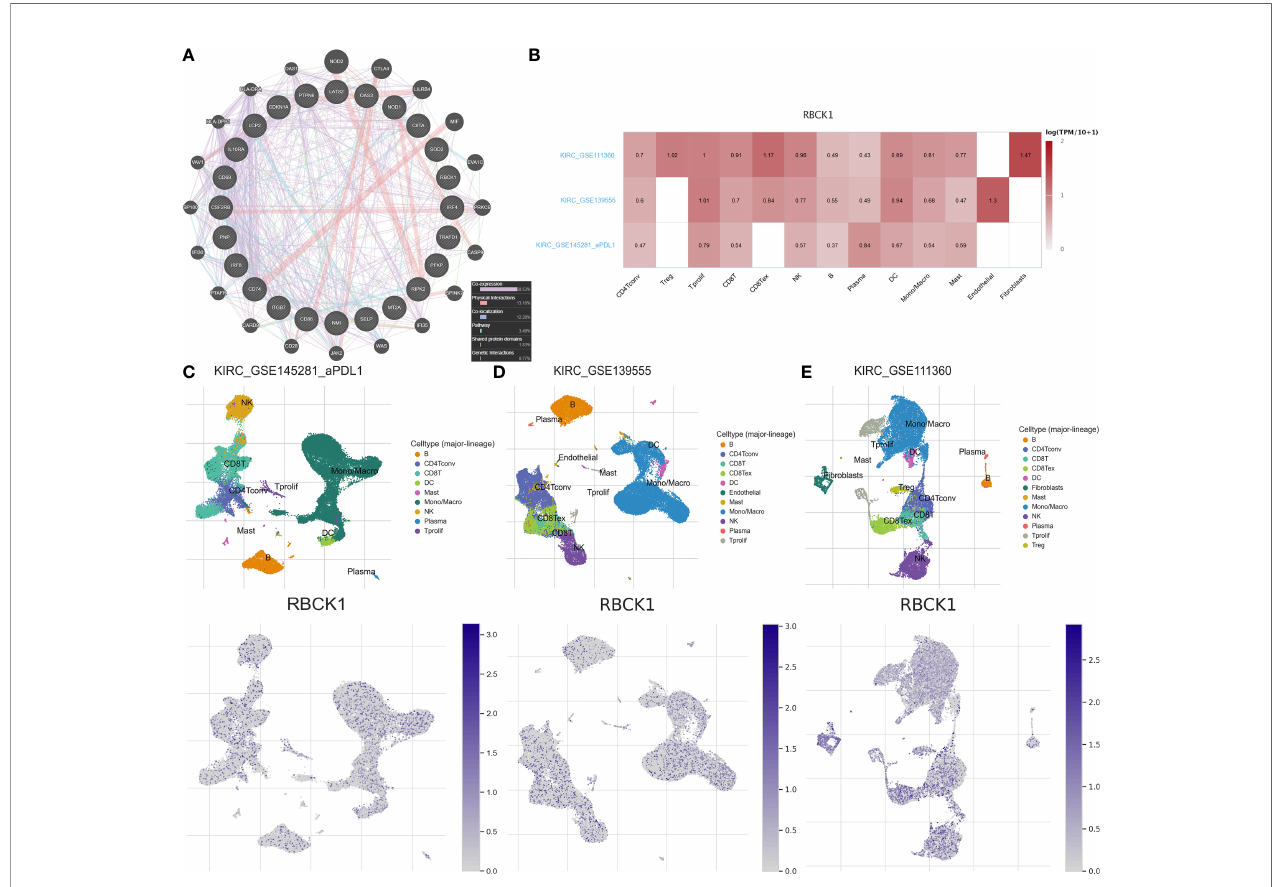
FIGURE 7 | Protein networks and single-cell localization of RBCK1. (A) Protein – protein interaction (PPI) network of the 24 IFN- g response signatures was constructed using GeneMANIA. (B) Three scRNA-seq datasets with detailed cell-type annotation at the single-cell level focusing on the tumor microenvironment for ccRCC. GSE111360 ( n = 2, number of cells = 23,130), GSE139555 ( n = 3, number of cells = 49,907), and GSE145281_PDL1 ( n = 4, number of cells = 44,220) were enrolled with correlation analyzed between RBCK1 expression and abundance of immune cell in fi ltrations. The higher the expression of RBCK1 in a single-cell subpopulation, the darker the red color is in the heatmap. (C – E) The heatmap showed the relatively high expression of RBCK1 in different cell types, such as CD 4+ , CD 8+ T cells, monocytes, macrophages, and NK cells across the three scRNA-seq